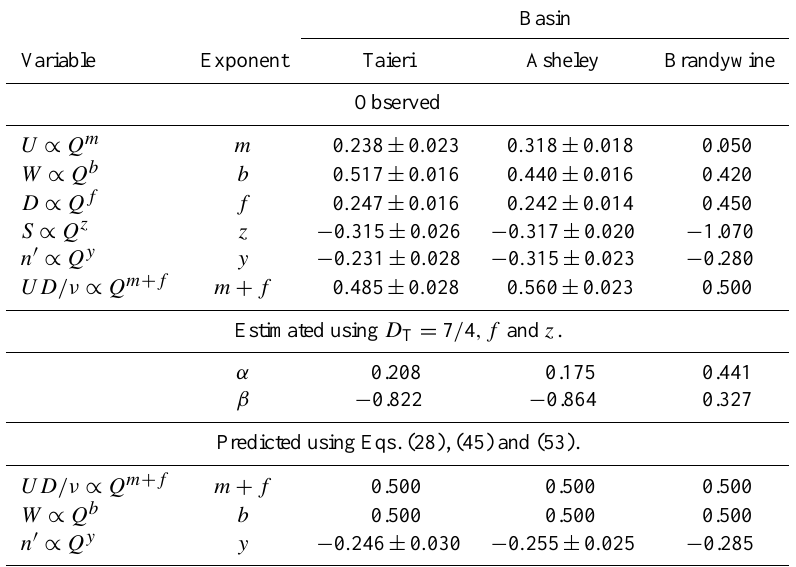
Table 1. Summary of observed and predicted H–G scaling exponents. The sources of the data are Ibbitt et al. (1998) for the Taieri River basin in New Zealand, McKerchar et al. (1998) for the Ashley River basin in New Zealand, and Leopold et al. (1964, Table 7.5, p. 244) for the Brandywine creek, PA in the United States. Basin Variable Exponent Taieri Asheley Brandywine